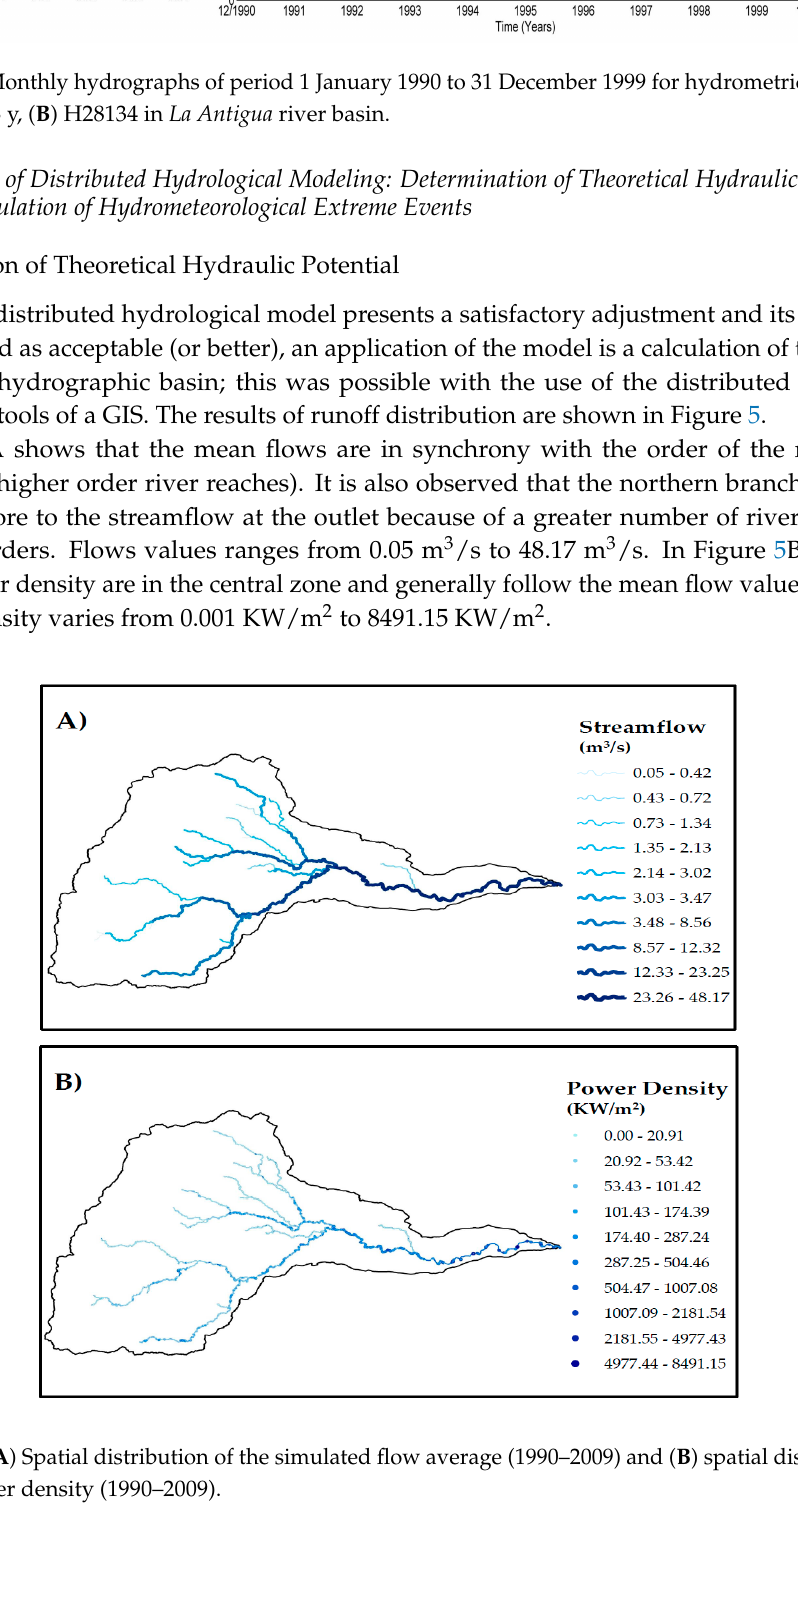
Figure 5. ( A ) Spatial distribution of the simulated flow average (1990–2009) and ( B ) spatial distribution of the power density (1990–2009).